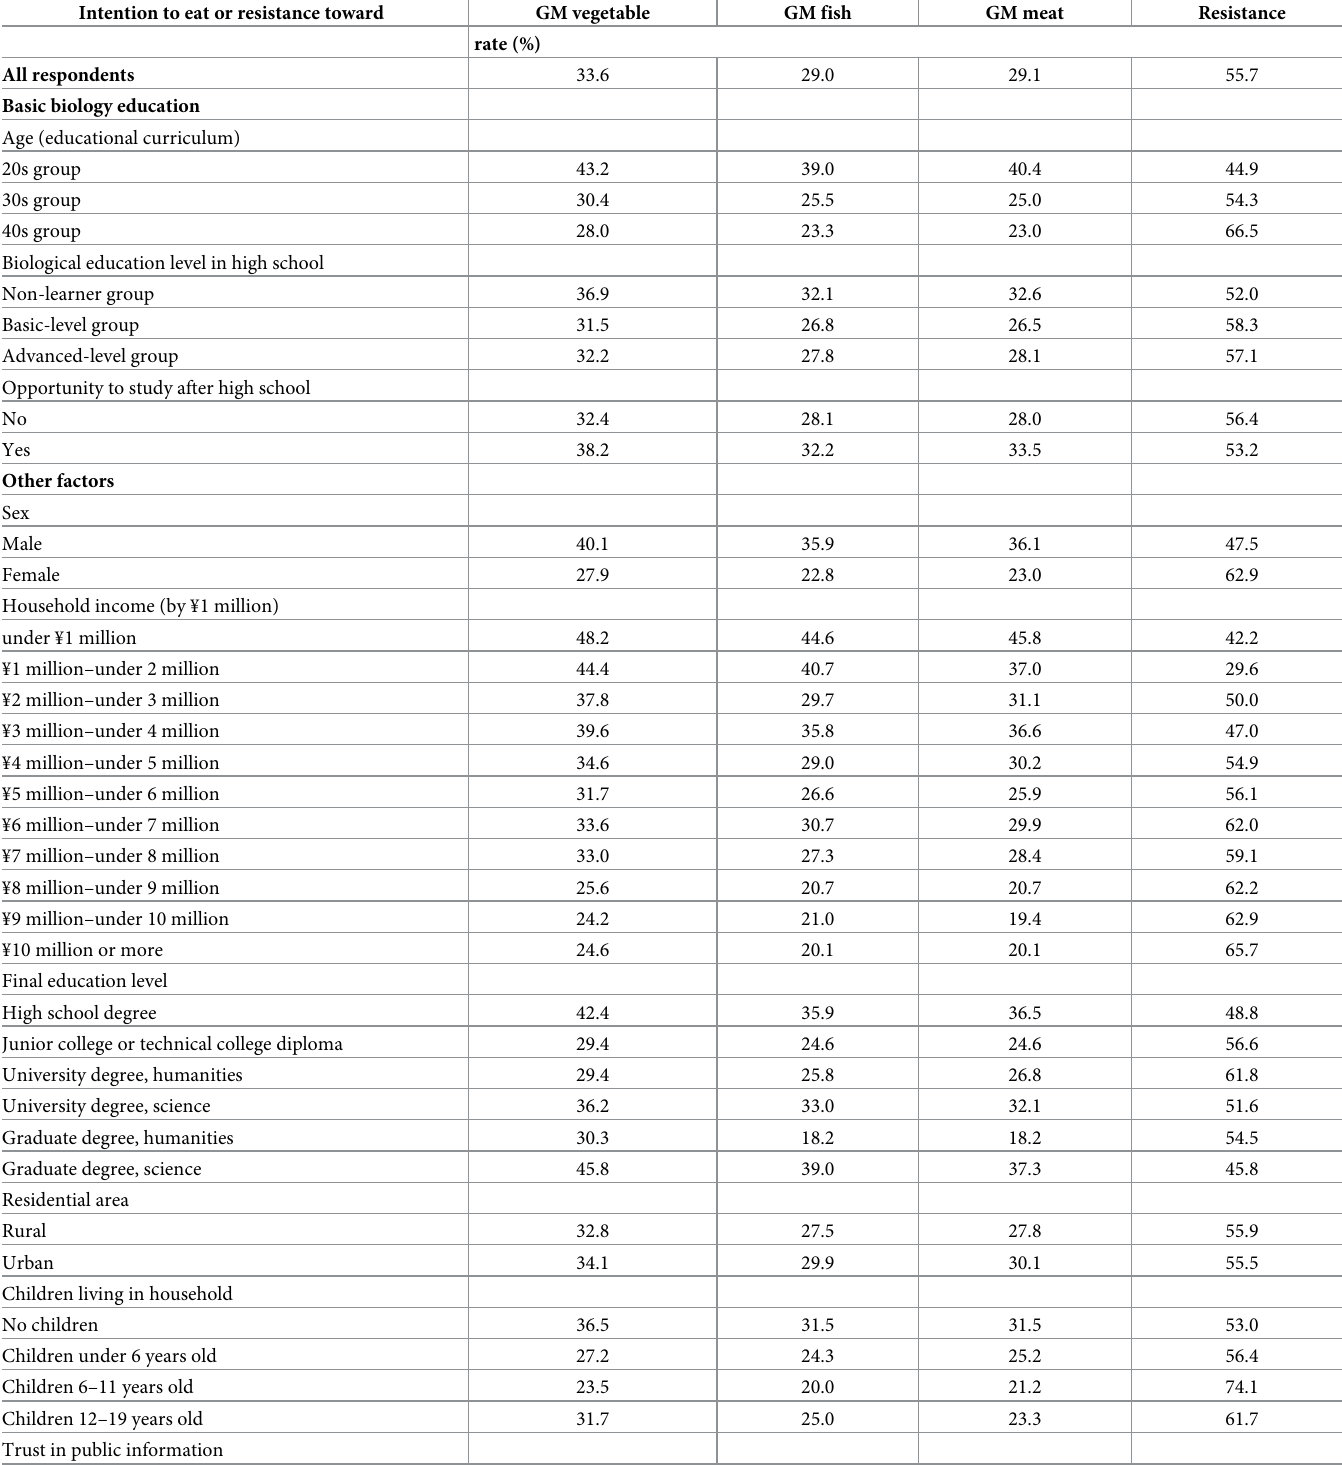
Table 5. Acceptance rates of GM food according to biology education, sociodemographic characteristics, trust in institutions, perception of benefits and risks, and practices of everyday life. Intention to eat or resistance